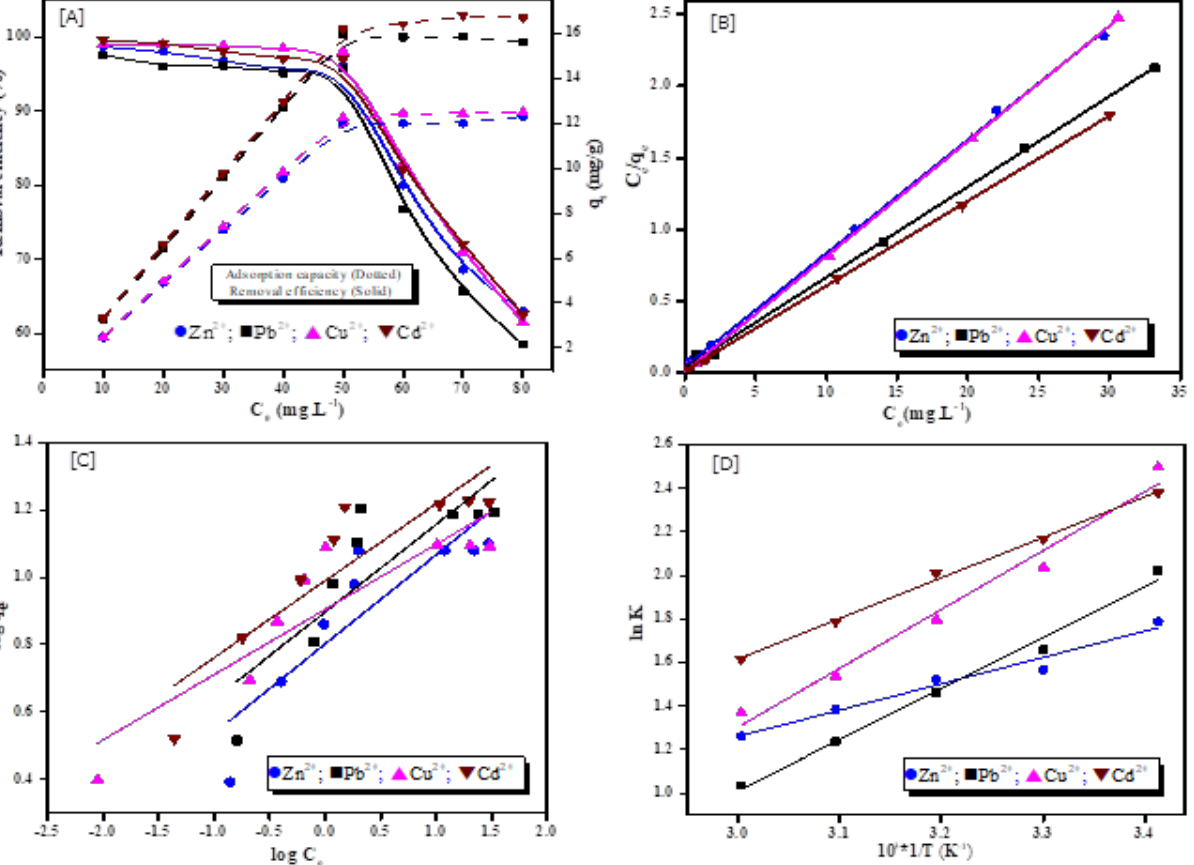
Figure 8. Effect of initial concentration on adsorption of Zn 2+ , Pb 2+ , Cu 2+ and Cd 2+ onto adsorbent ( A ), Langmuir model ( B ), Freundlich model ( C ), and adsorption thermodynamic model ( D ). (Adsorbent dosage = 4 gL −1 , adsorption temperature = 20–60 °C, initial concentration of metal ions = 10–80 mg·L −1 , and reaction time = 60 min).